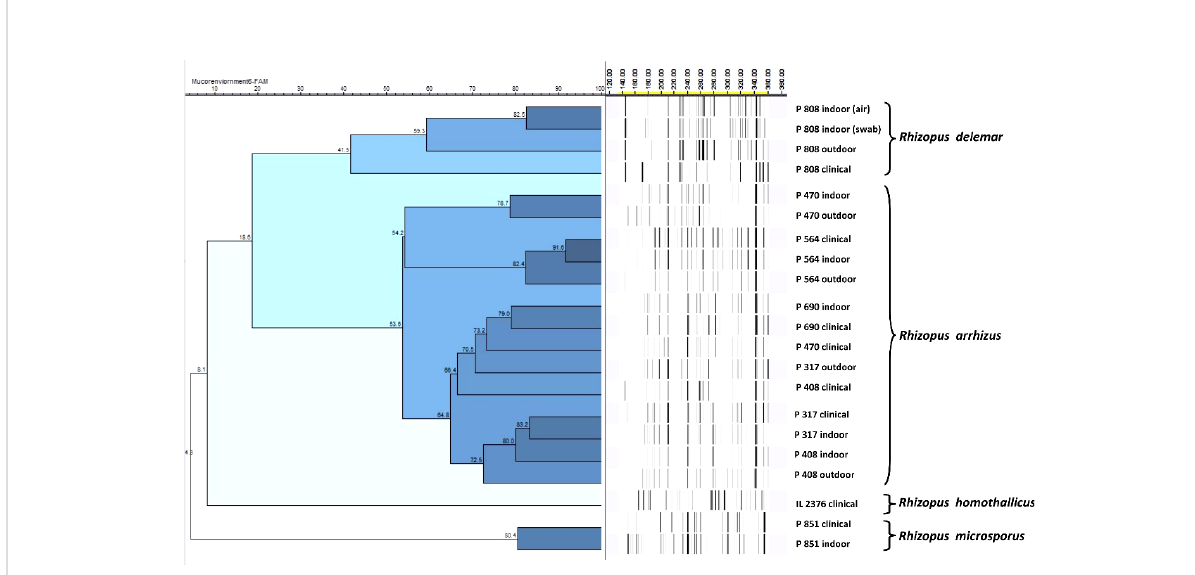
FIGURE 3 Representative ampli fi ed fragment length polymorphism (AFLP) of clinical and environmental isolates from patients and their respective residential areas. The scale bar represents the percentage similarity between the